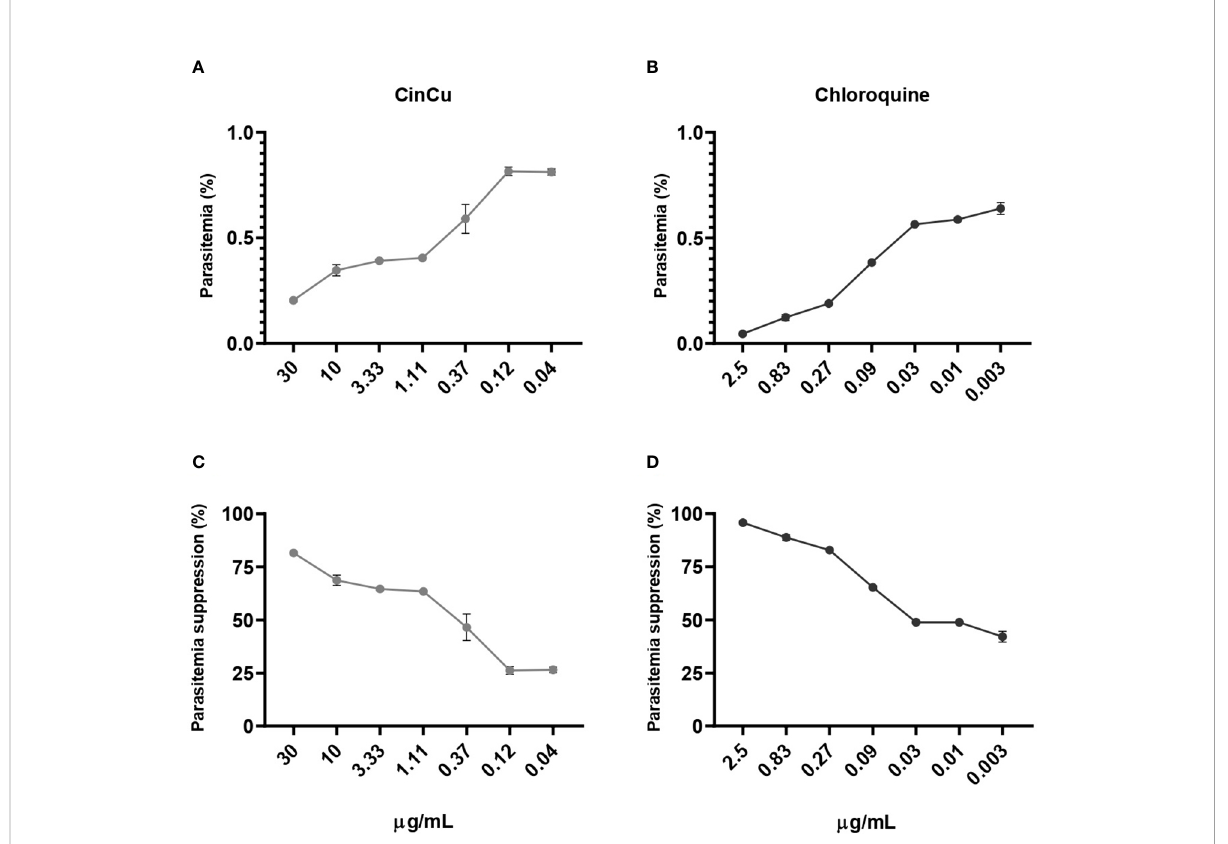
FIGURE 3 In vitro antiplasmodial activity of the CinCu and chloroquine against P . falciparum W2 strain. The dose-dependent curve of the parasitemia of CinCu (A) and chloroquine (B) . The parasitemia suppression of CinCu (C) and chloroquine (D) , respectively. Results are presented as mean ± SD of two replicates in two independent experiments. Suppression of the parasite growth was calculated in relation to control cultures with no